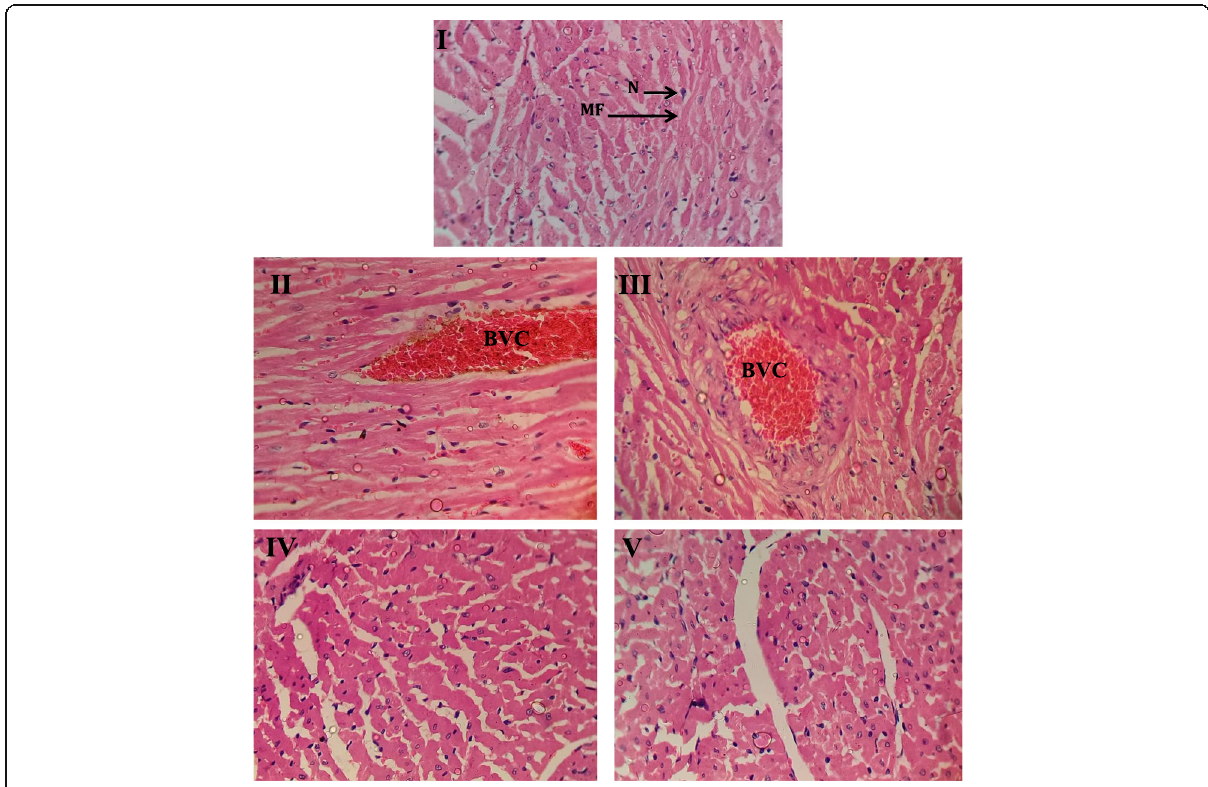
Fig. 1 Histological examination of the heart tissue of all experimental rats, at the end of experiments. I: Control rats, II: rats fed HFD without supplements, III: rats fed HFD + supplements, IV: rats fed HFD + supplements + 400mg chitosan and V: rats fed HFD + supplements + 800mg chitosan. BVC: blood vessel congestion, MF: myocardial fiber and N: nucleus. Haematoxylin & Eosin,